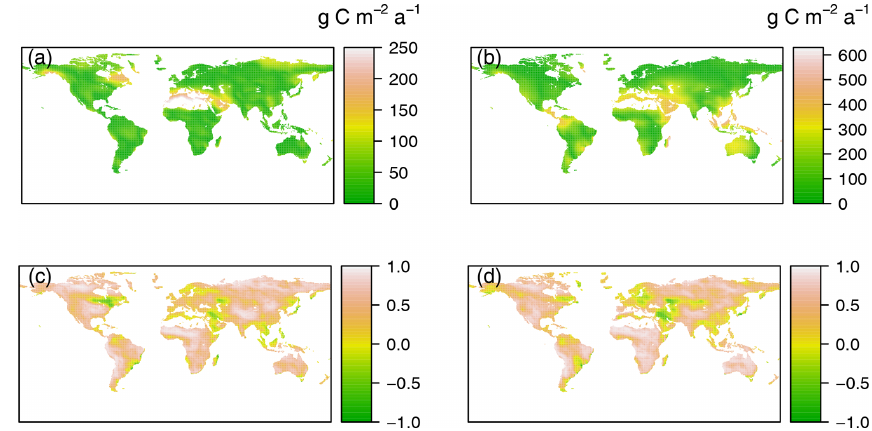
Figure 3. Comparing the data-derived RH dataset with Hashimoto RH (a, c) and mean RH of TRENDY models (b, d) based on absolute distances (gCm − 2 a − 1 , a, b ) and cross-correlations (c, d) . The absolute distances and cross-correlations were calculated using comparison map profile method (Gaucherel et al., 2008).